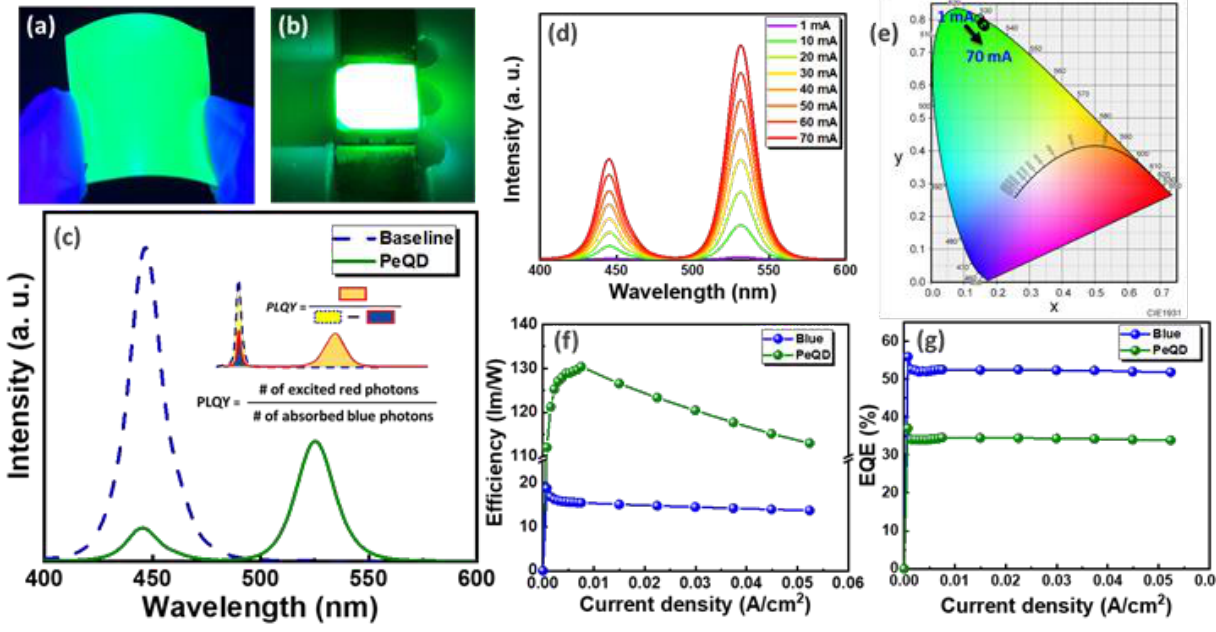
Figure 2. Optical properties of green PeQD film. ( a ) UV lamp, ( b ) light color image of blue LED excitation. ( c ) Emission spectrum (20 mA). Current variation test (1–20 mA) ( d ) emission spectrum image, ( e ) CIE color coordinates, ( f ) luminous efficiency, and ( g ) EQE.